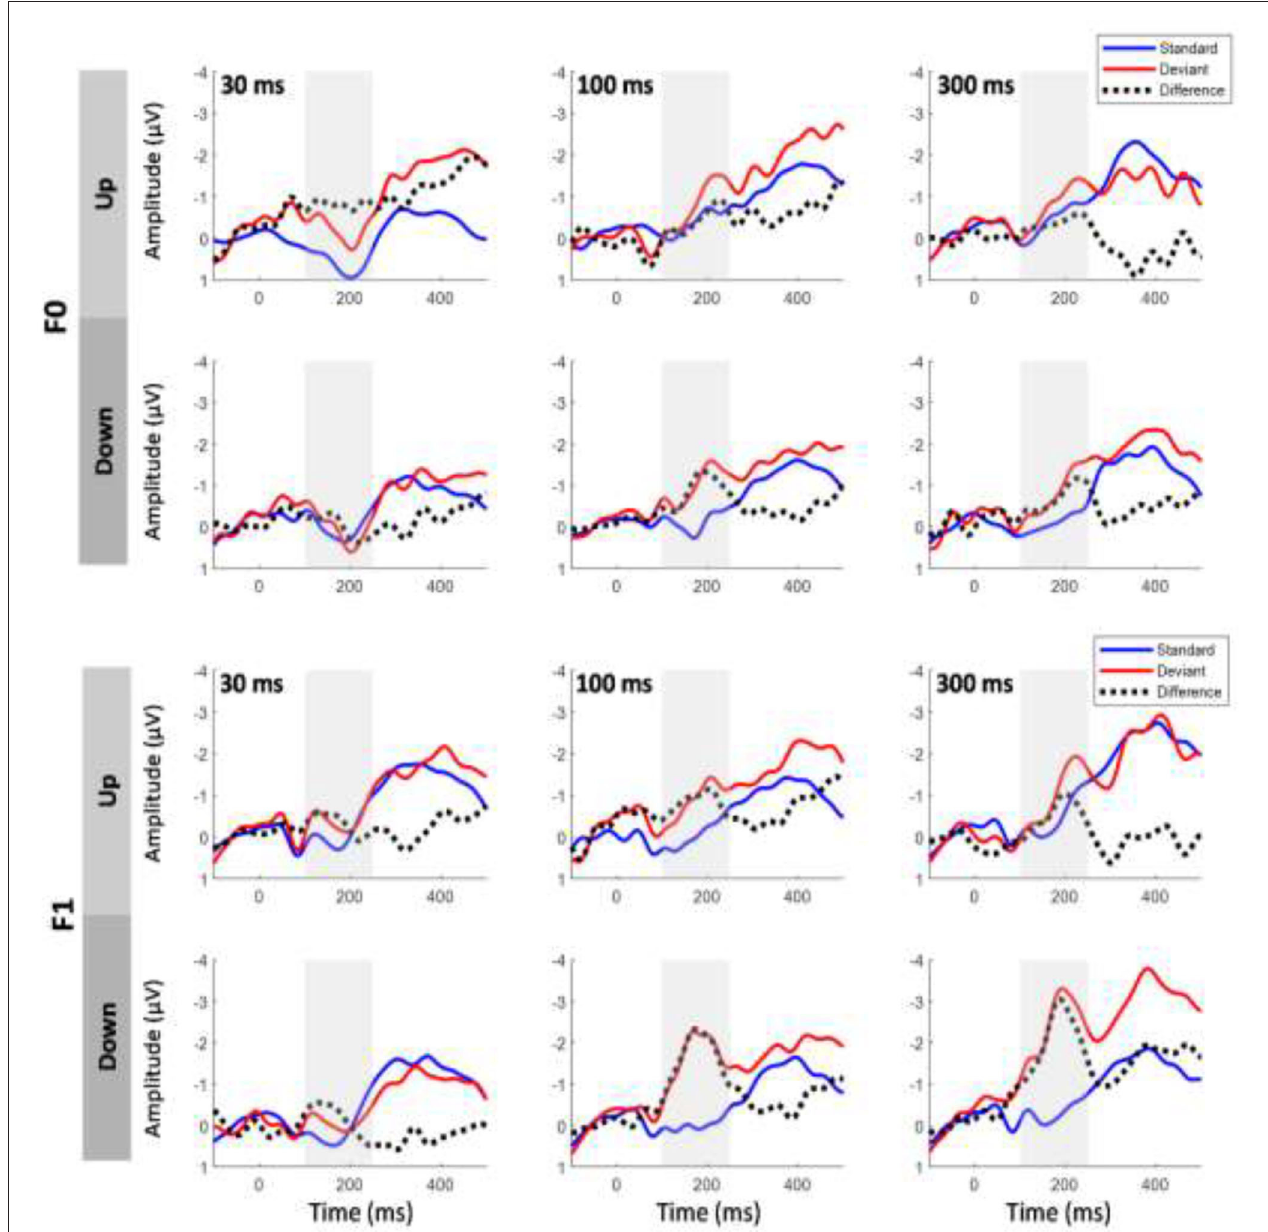
FIGURE 2 | Grand average event-related potential (ERP) waveforms evoked by the standard and deviant stimuli and the difference waveforms at electrode Fz based on same-stimulus computation. Top six panels show upward and downward sweeps across all three timescales for F0 contours, and bottom six panels show the same conditions for F1 contours. Gray shaded area indicates mismatch negativity (MMN) time window. Significant MMNs were elicited in both sweep directions across all durations at the F0 and F1 frequencies.